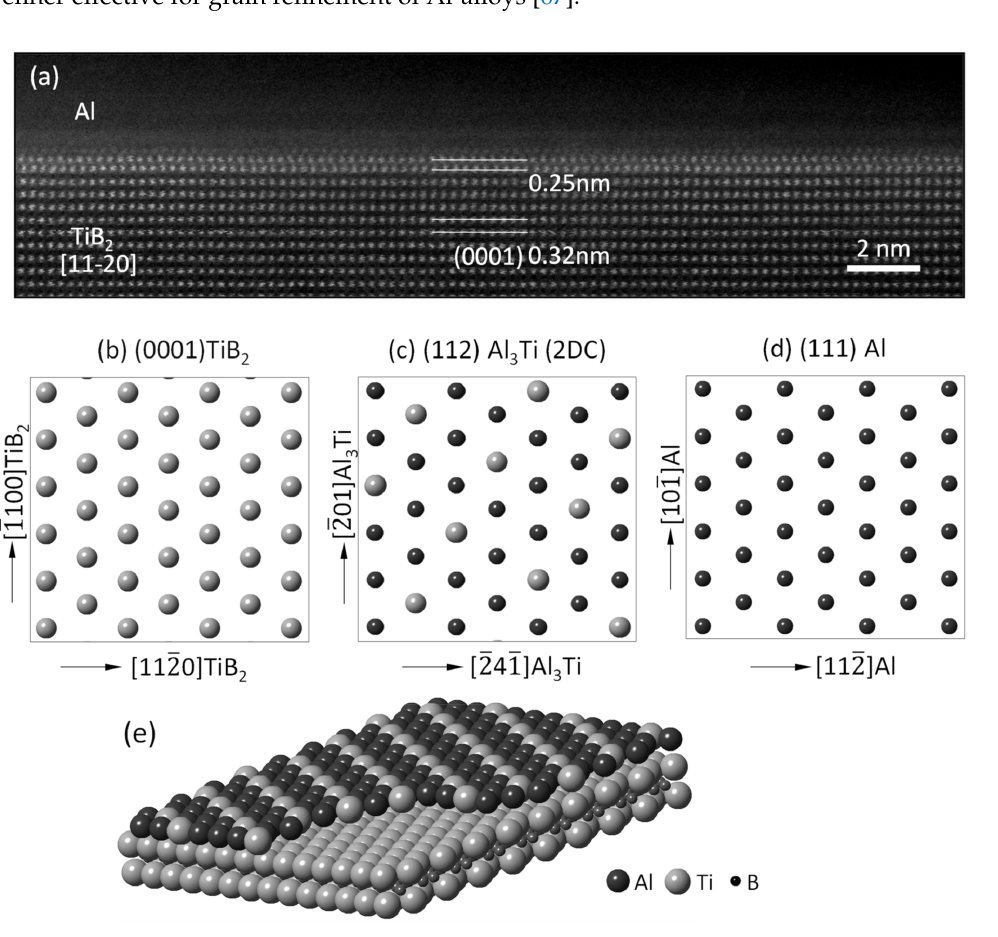
Figure 4. Formation of the (112) Al 3 Ti 2DC as new substrate in the Al/TiB 2 system [67] (Copyright 2017 The Minerals, Metals & Materials Society. Used with permission). ( a ) HAADF image showing the existence of (112) Al 3 Ti 2DC (2-dimensional compound) on top of the TiB 2 surface; ( b ) Ti-terminated (0 0 0 1) plane of TiB 2 surface, ( c ) (112) Al 3 Ti 2DC; ( d ) (111) plane of Al; and ( e ) 3D construction of the Al 3 Ti 2DC layer on TiB 2 surface. It indicates that Al 3 Ti 2DC forms at the interface of the liquid Al/TiB 2 , and changes the (0001) TiB 2 ( − 4.22% misfit) into an extremely potent TiB 2 /Al 3 Ti 2DC substrate (0.09%